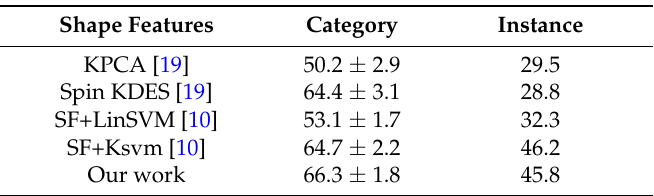
Table 2. Comparisons to state-of-the-art partial-to-global shape descriptors. Accuracy is in percentage. ± refers to standard